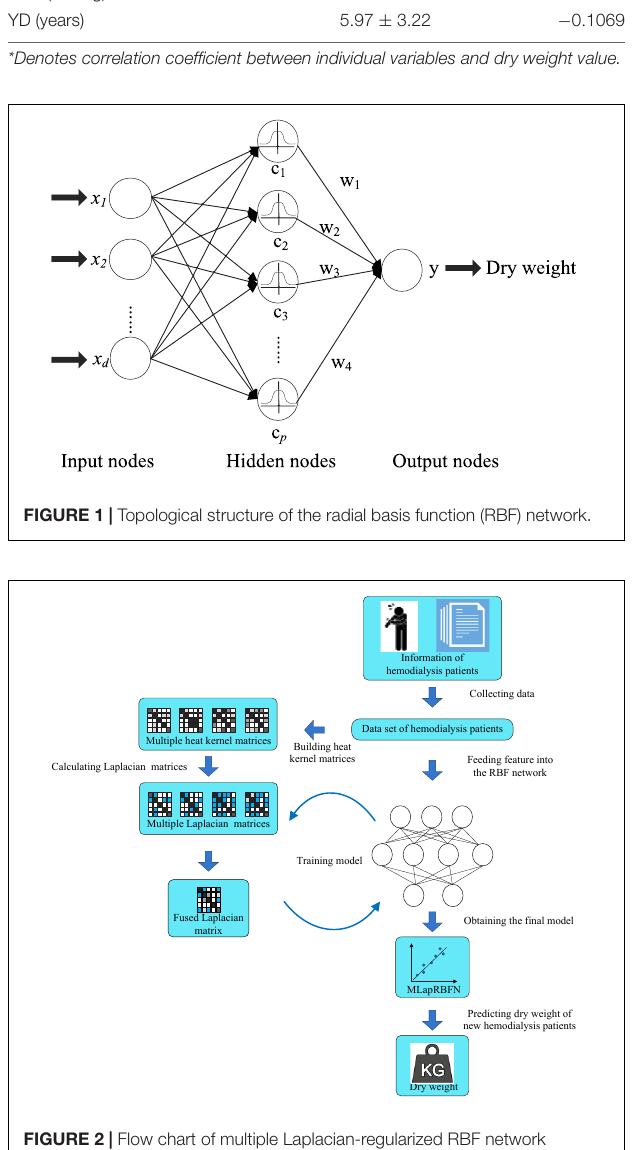
model. The summary of information is shown in Table 1